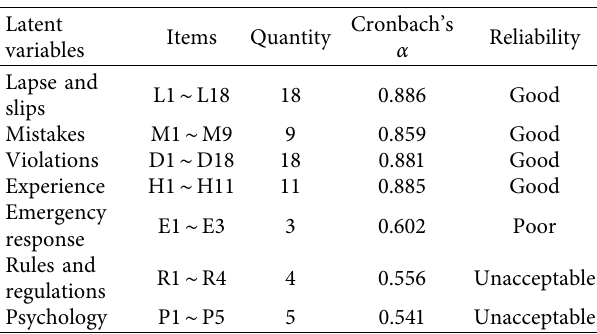
Table 2: Internal consistency level corresponding to Cronbach’s α . Table 3: Reliability test of initial latent